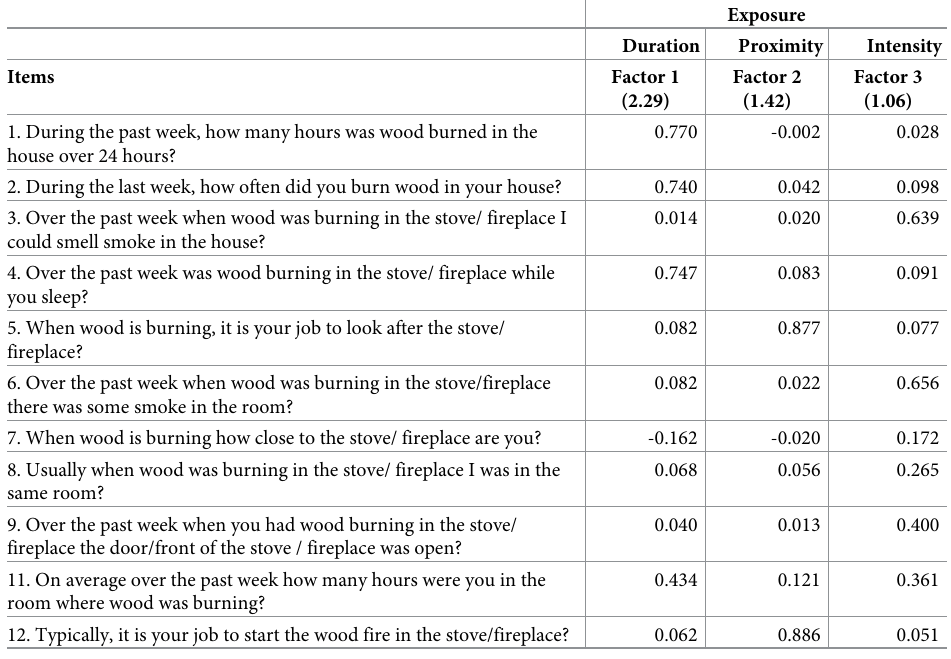
Table 5. Rotated factor loadings and eigenvalues obtained from three factor exploratory factor analysis (EFA) using principal axis factoring with promax rotation. Items Factor 1